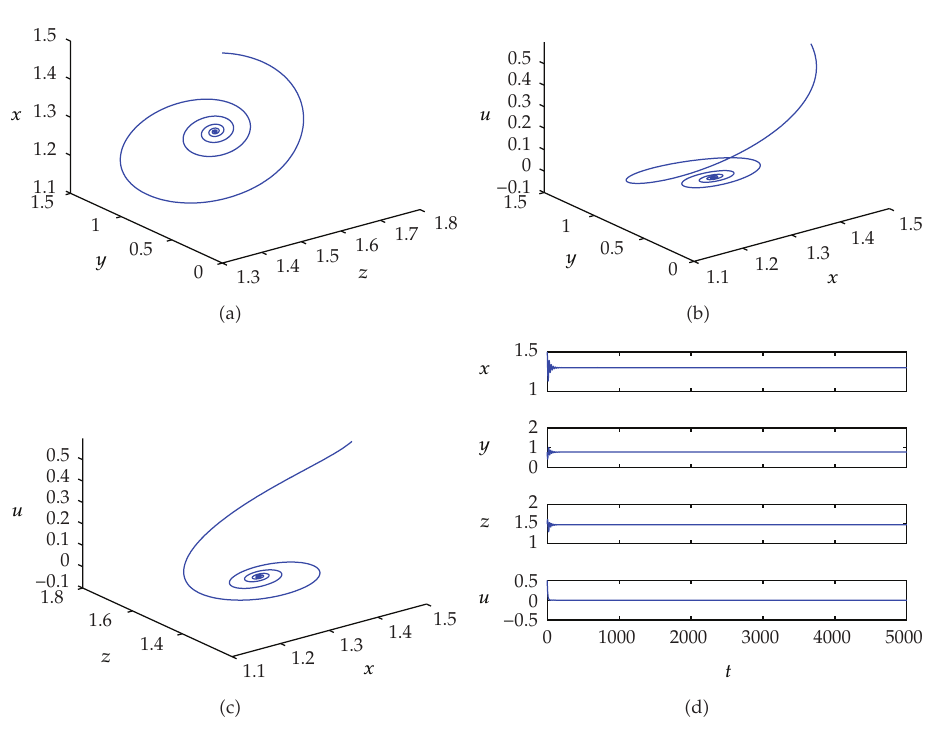
Figure 5: The stable equilibrium point S 1 of the controlled system (cid:6) 4.1 (cid:7)